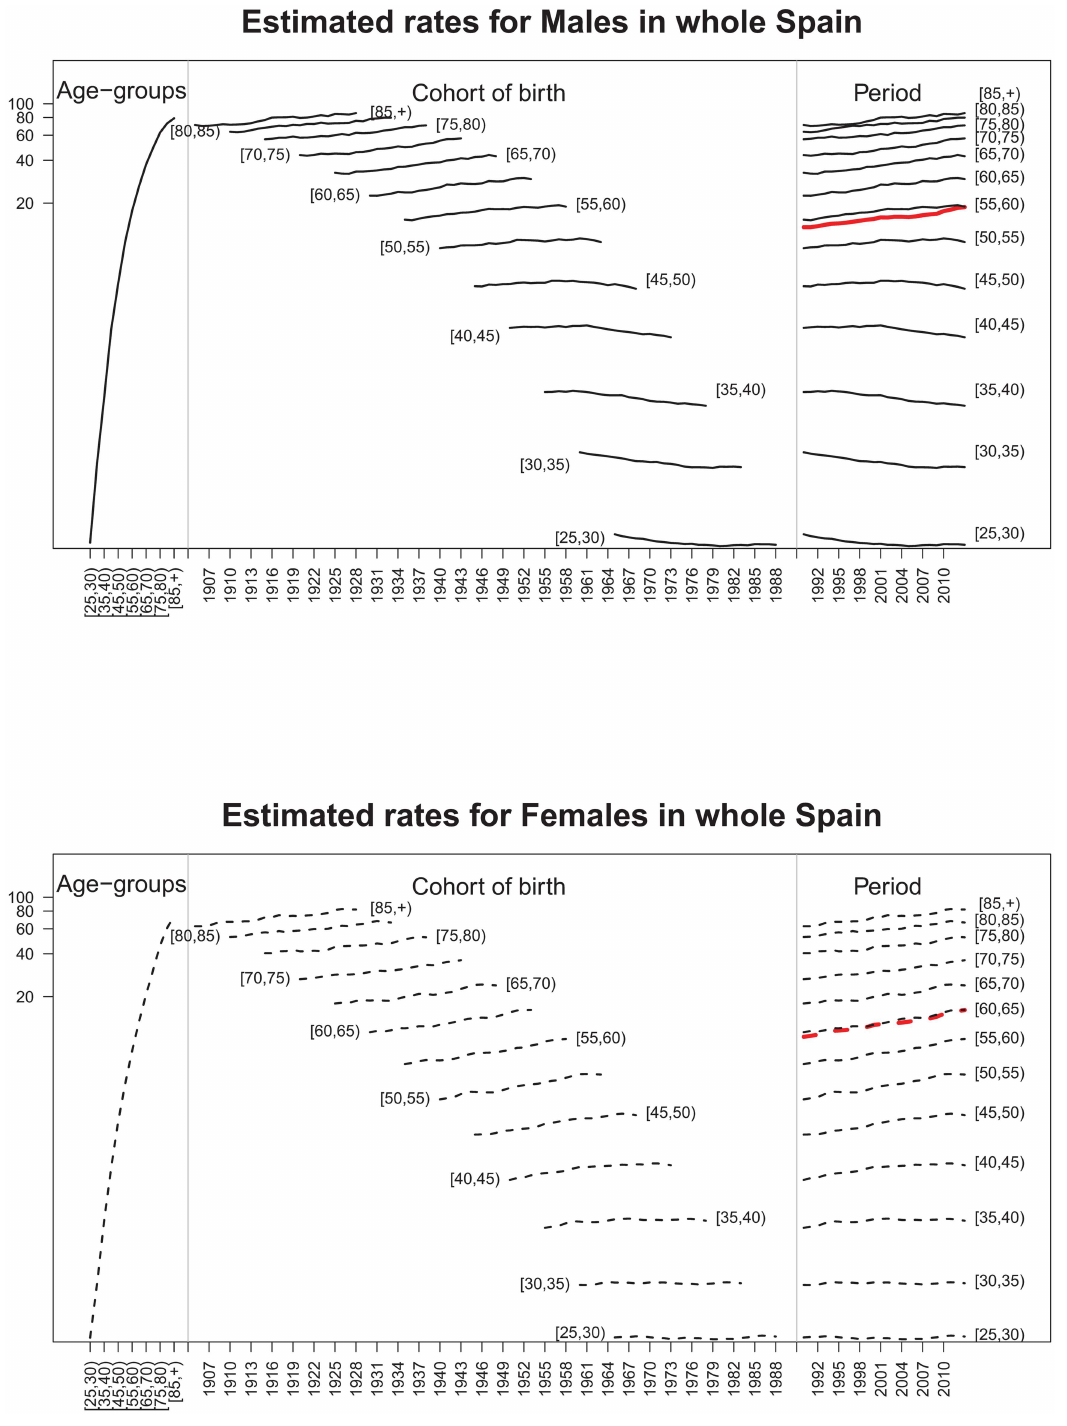
Fig 6. Age-specific pancreatic cancer mortality rates (on a semi-logarithmic scale on the y-axis) by birth cohort and period for whole Spain.